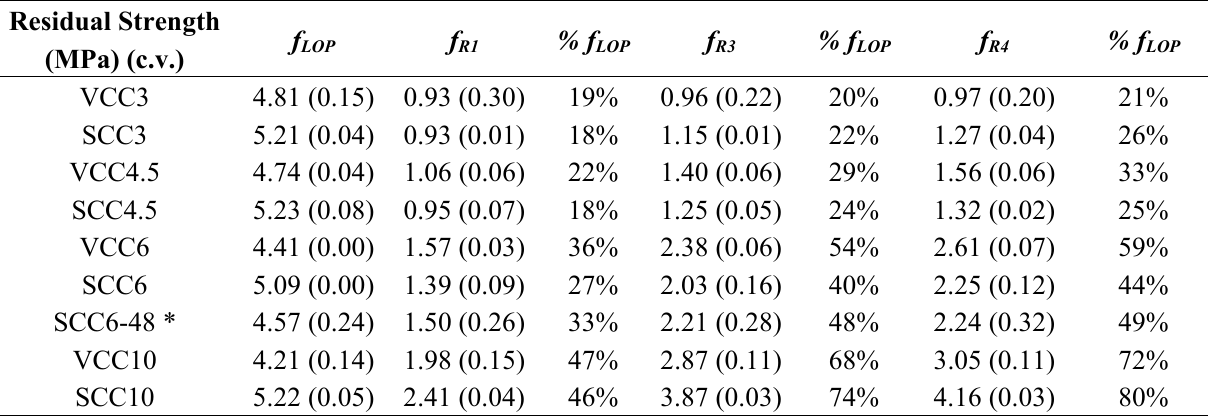
Table 3. Residual strengths obtained from flexural tensile strength tests [19,22] following EN 14651